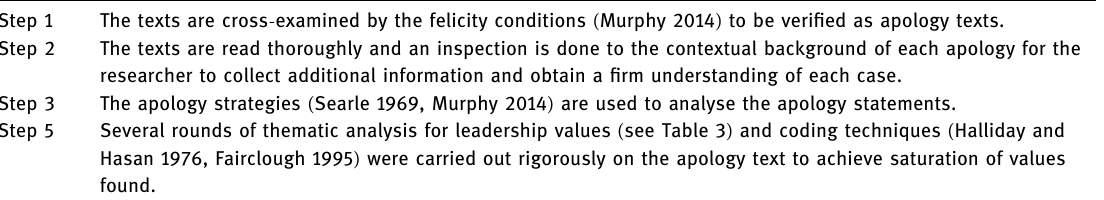
Table 4: Procedure for data